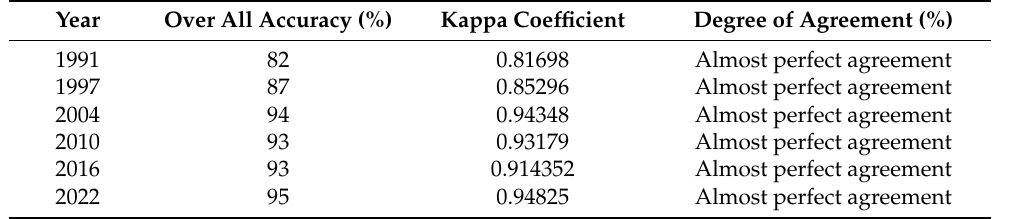
Table 4. Classification degree of